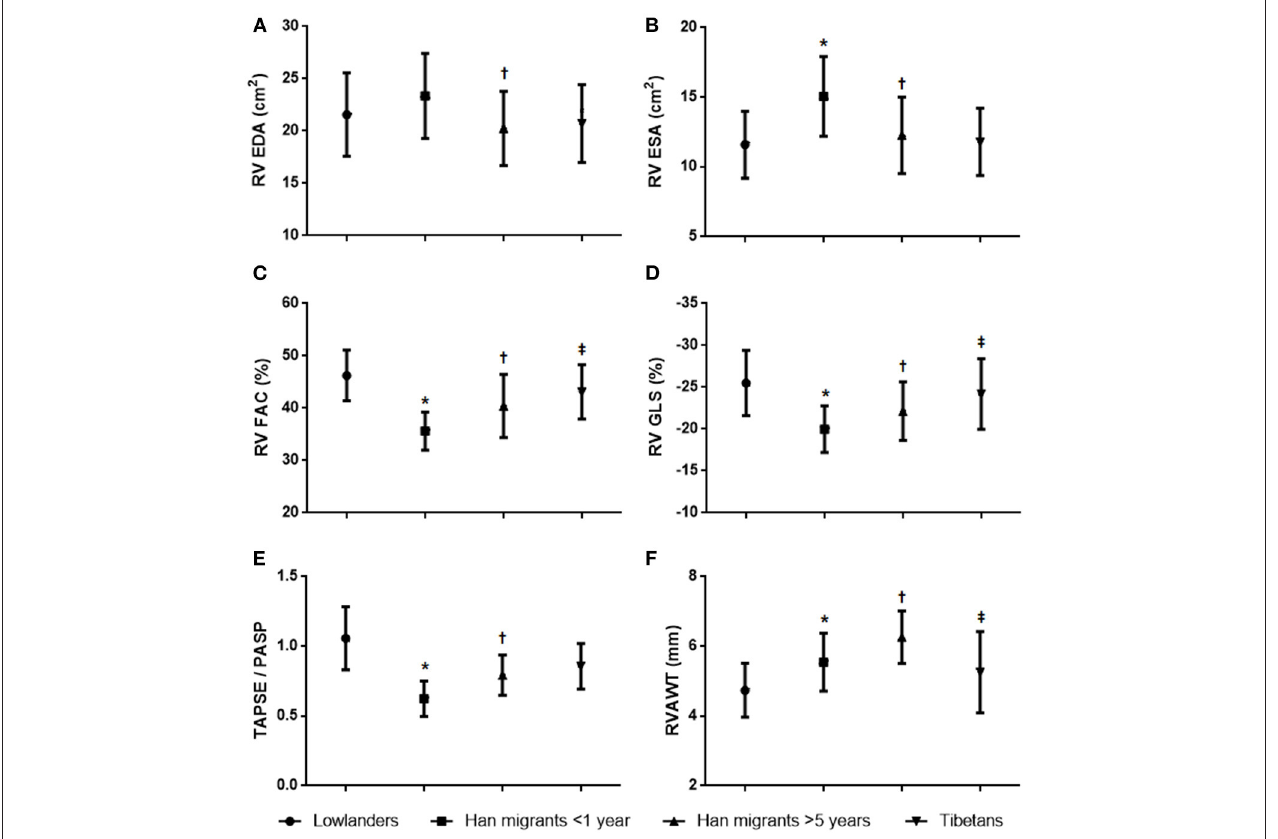
FIGURE 1 | Between-group comparisons of right ventricular characteristics. (A) Right ventricular end-diastolic area. (B) Right ventricular end-systolic area. (C) Right ventricular fractional area change. (D) Right ventricular global longitudinal strain. (E) Tricuspid annular plane systolic excursion/pulmonary artery systolic pressure. (F) Right ventricular anterior wall sickness. * p < 0.05 Han migrants < 1 year vs. lowlanders; † p < 0.05 Han migrants > 5 years vs. Han migrants < 1 year; ‡ p < 0.05 Tibetans vs. Han migrants > 5